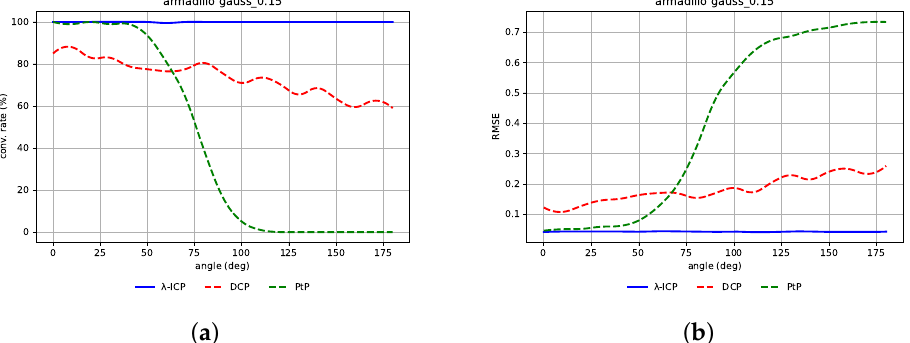
Figure 14. ( a ) Convergence rate of λ -ICP (blue), DCP (red), PtP (green) algorithms for Armadillo with Gaussian noise, σ = 0.15; ( b ) mean RMSE (for transformation matrices) of λ -ICP (blue), DCP (red), PtP (green) algorithms for Armadillo with Gaussian noise, σ =